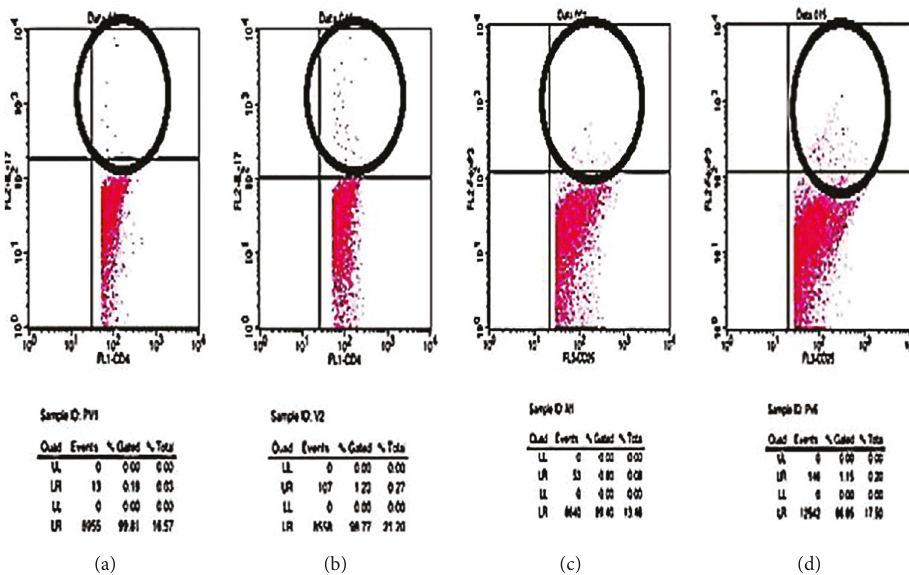
Figure 7: Scatter graph of Th17 proportion (pointed with a black circle) in the control group (a) and S. flexneri 49.8kDa subunit pili vaccinated group (b). Scatter graph of T-regulatory proportion (pointed with black circles) in the control group (c) and S. flexneri 49.8kDa subunit pili vaccinated group (d).